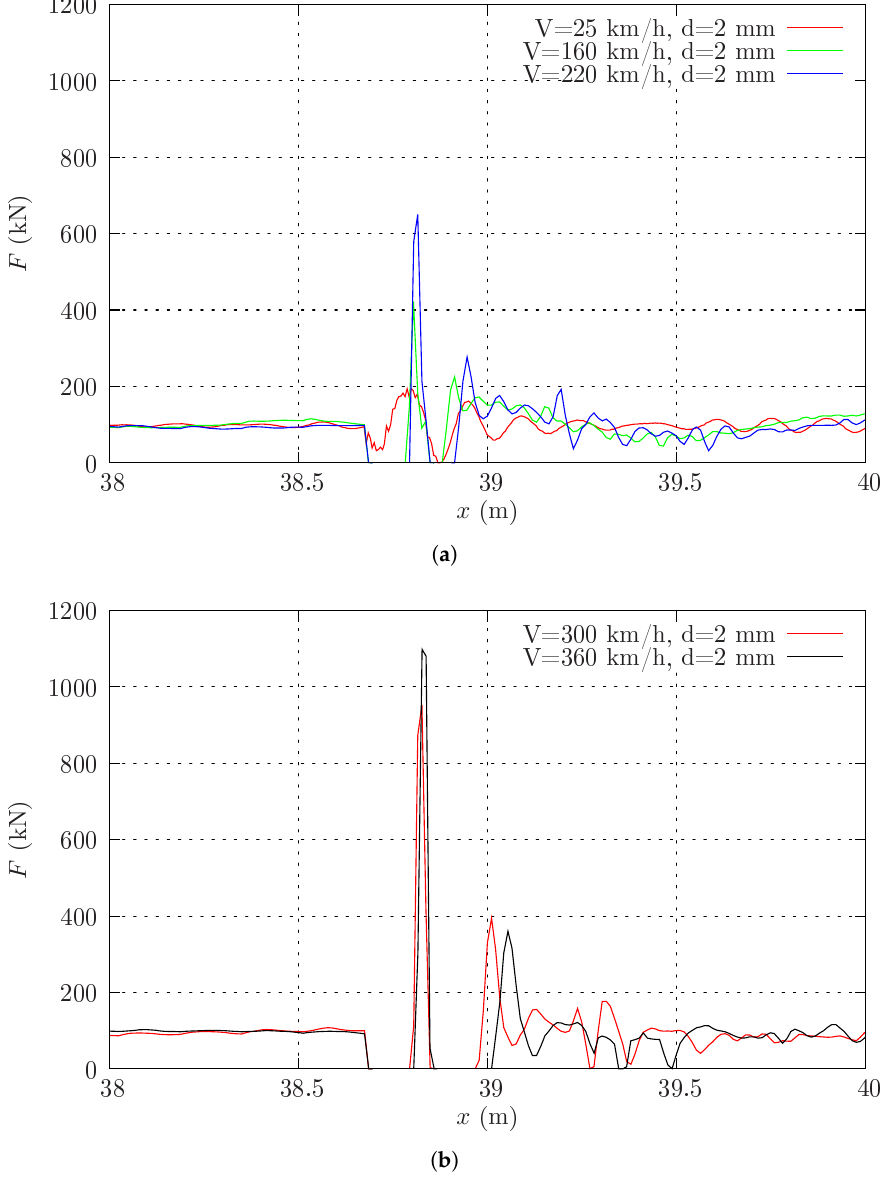
Figure 11. Variation of the dynamic load along the slab track for various vehicle speeds due to a wheel flat ( d = 2 mm). ( a ) V = 25, 160, and 220 km/h; ( b ) V = 300 and 360